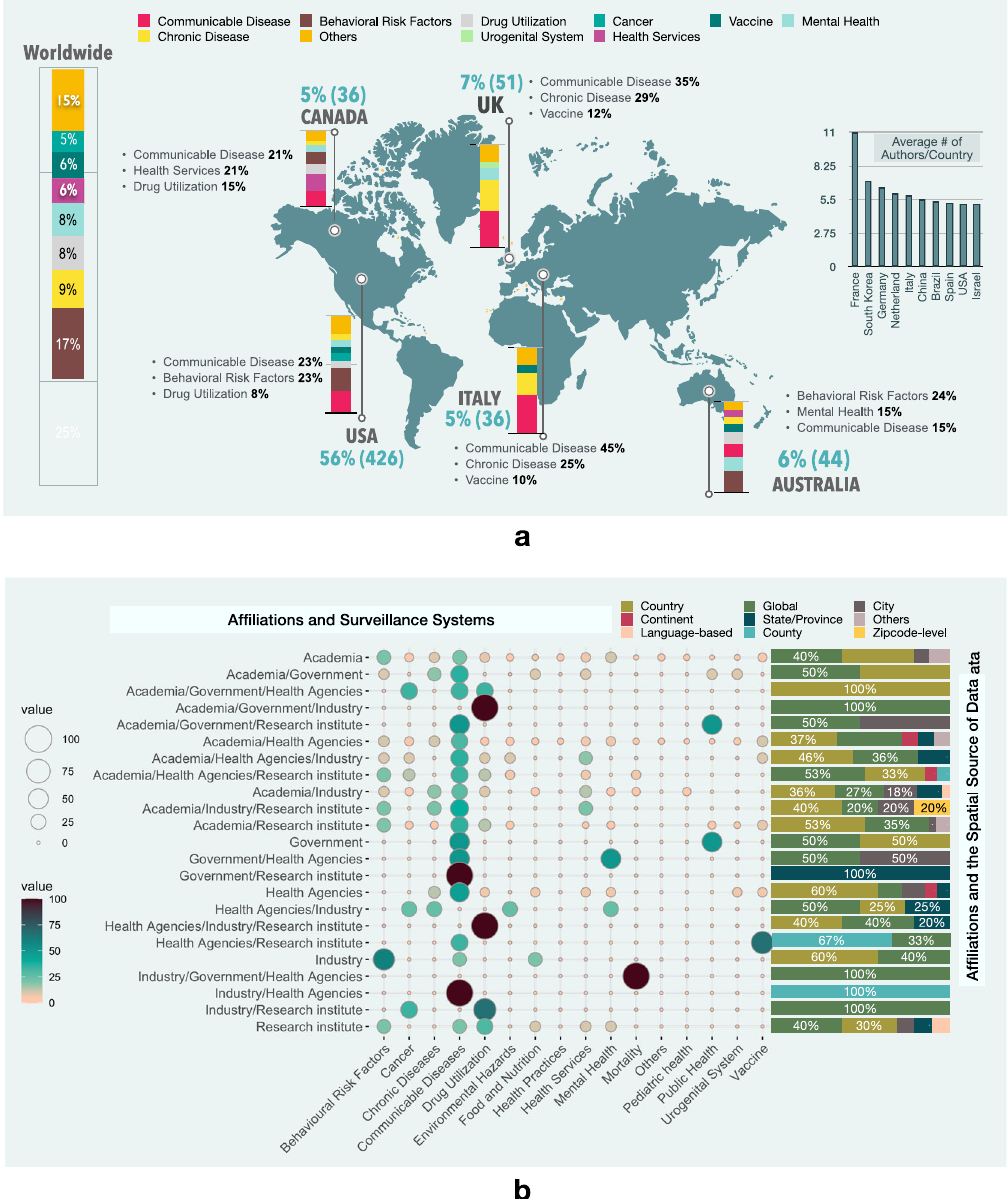
Fig. 3 The distribution of studies based on country and af fi liation, mapped to different PHS themes. a Top fi ve countries and PHS themes. b The frequency of different combinations of af fi liations, PHS themes and the average number of authors per